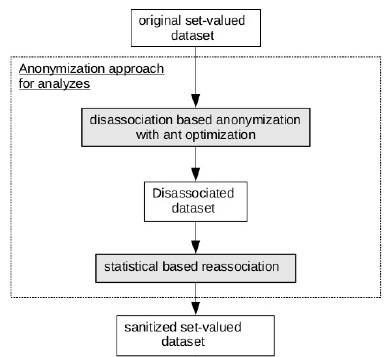
Figure 1. Synthesis of the anonymization of setvalued datasets based on disassociation optimized by ant colonies and a reconstruction respecting the statistical item appearance frequencies.